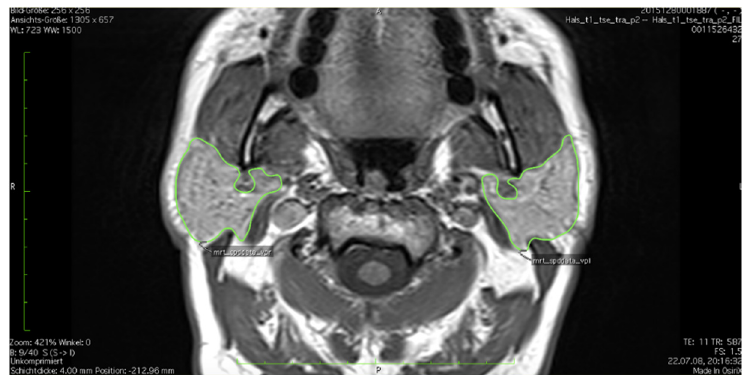
Figure 1. Example of the outlining of the parotid tissue in one single slice, axial T1-weighed MRI (Vv. retromandibulares are left out).